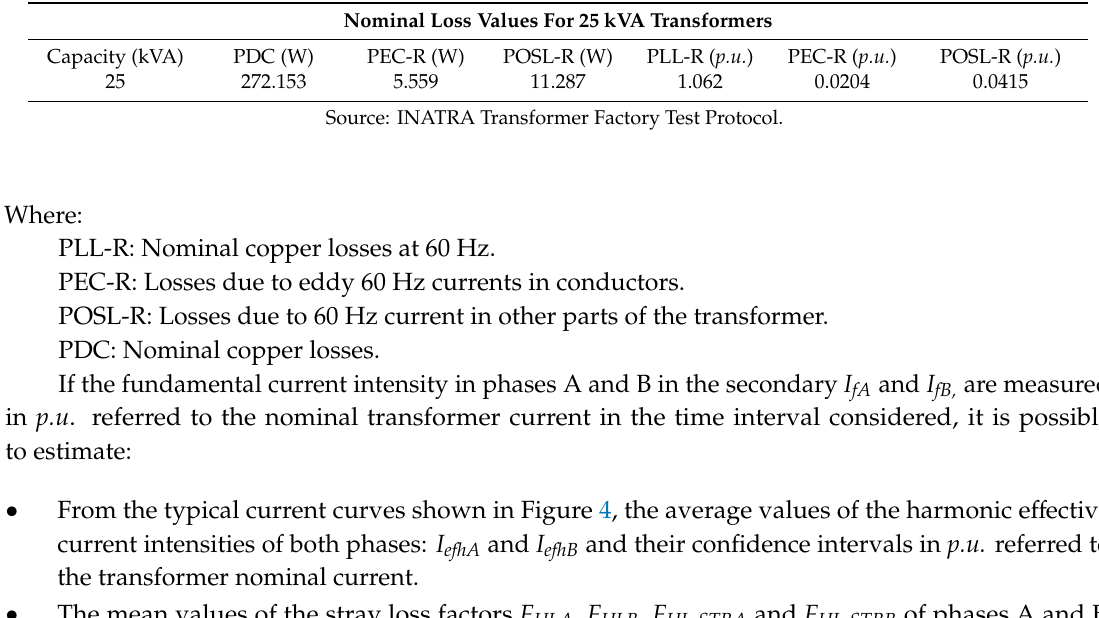
Table 5. Nominal losses in 25 kVA, INATRA transformers.